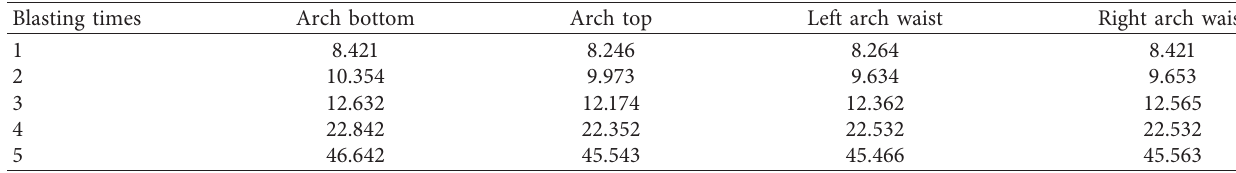
Table 3: Peak displacement at each measuring point of 3-3 profile (mm).